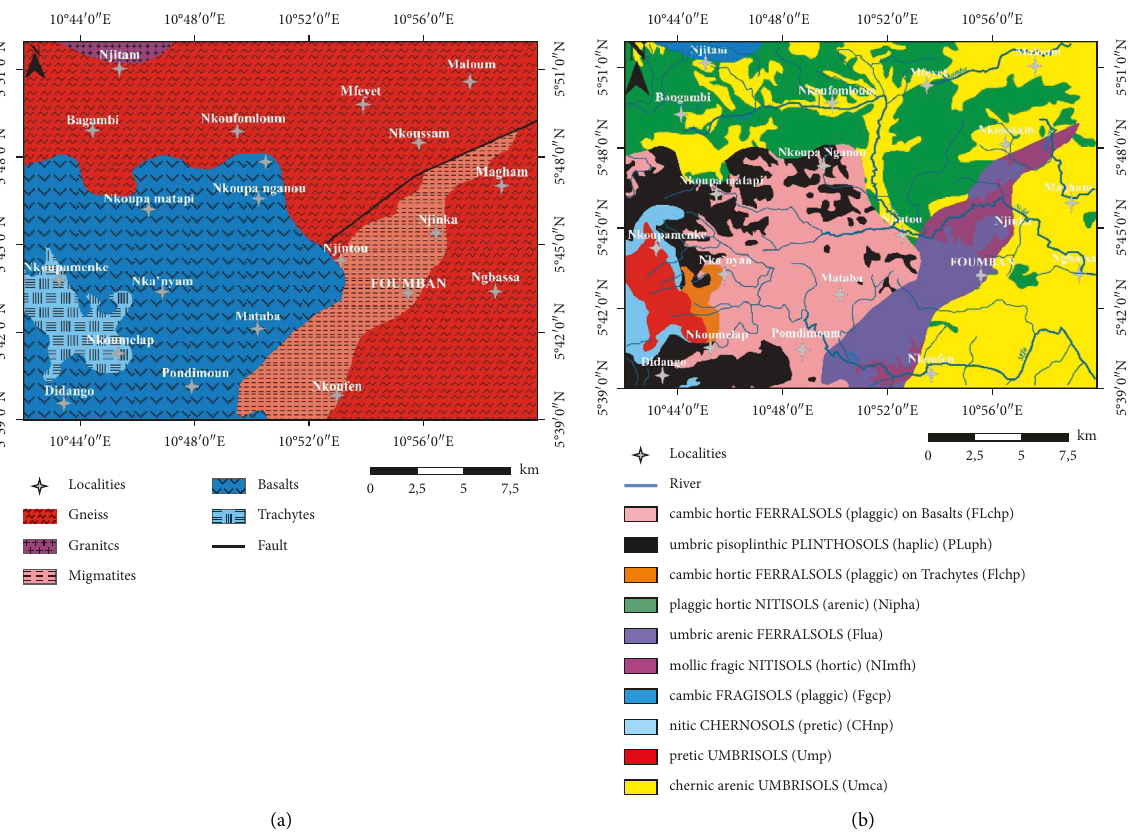
Figure 2: Geological sketch map and soil map of the study area. (a) Geological map of Foumban (after) [23]; and (b) map of the distribution of soil groups in the study